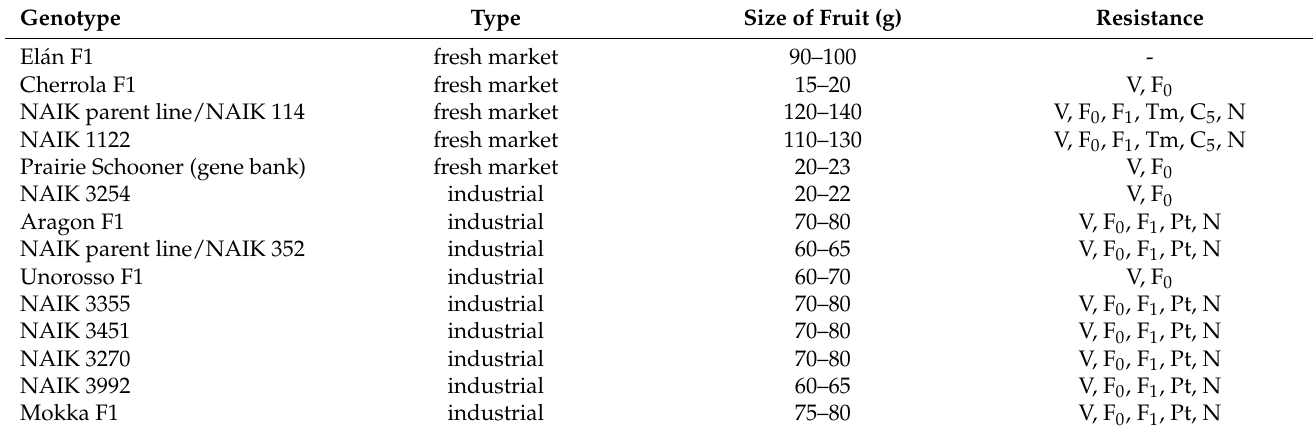
Table 5. Basic information on the analyzed tomato samples. Resistance against: V = Verticillium dahlia, F0 = Fusarium oxysporum f.sp. Lycopersici race 0; F1 = Fusarium oxysporum f.sp.